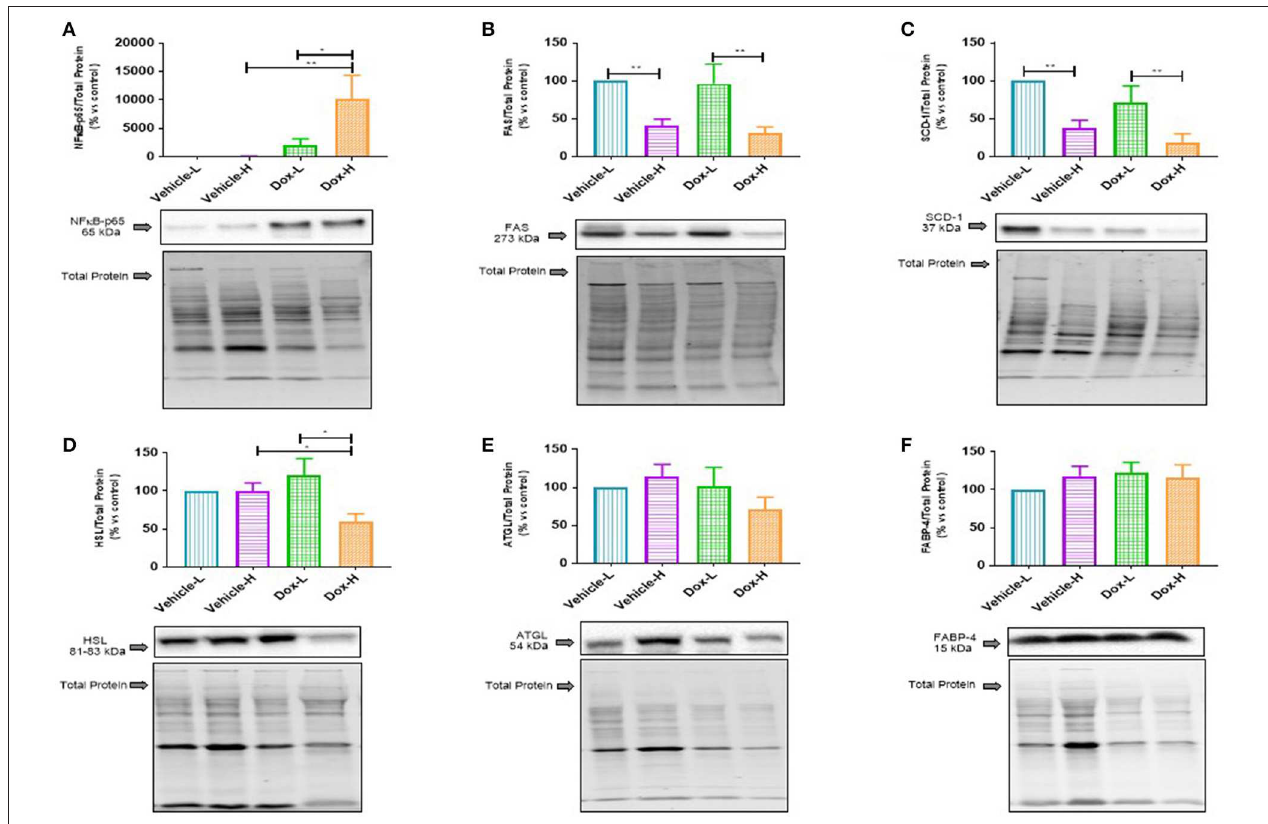
FIGURE 7 | Western blot analysis of lipid metabolism marker protein expression in mammary adipose tissue of vehicle control and doxorubicin treatment groups on LFD and HFD; (A) NF κ B-p65, (B) FAS, (C) SCD-1, (D) HSL, (E) ATGL, and (F) FABP4. Results are presented as mean ± SEM ( n = 6–8). Two-way ANOVA with Fisher’s LSD post hoc correction was employed and p < 0.05 was considered as statistically significant. * p < 0.05, ** p <